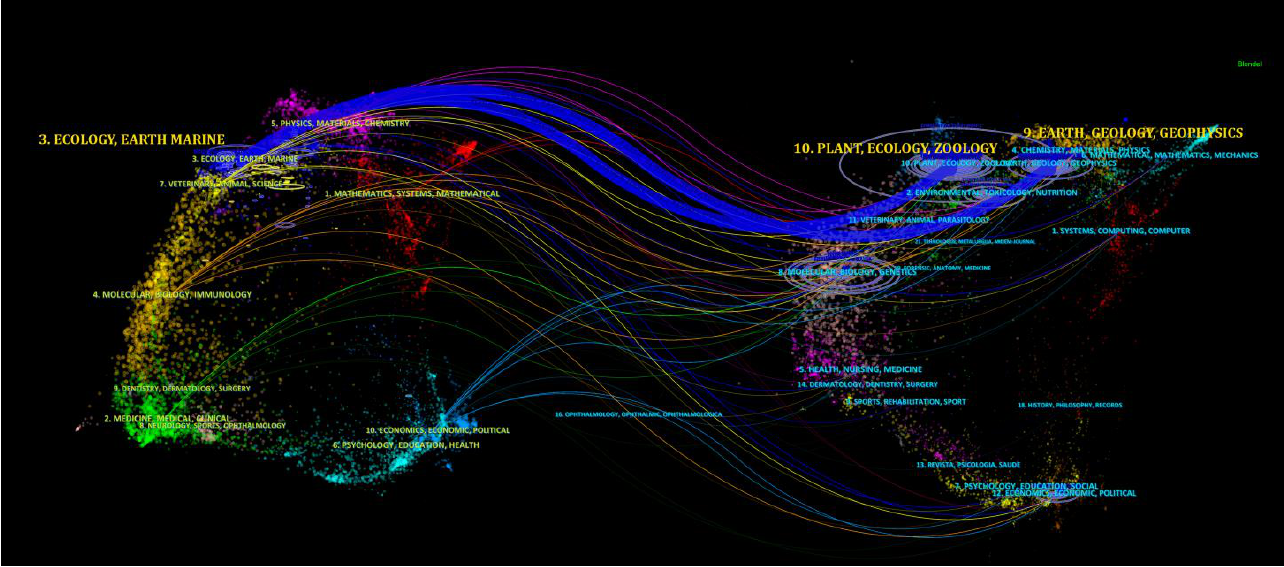
Figure 13. Evolution of research topics in mangrove-climate change studies from 1977 to 2021.